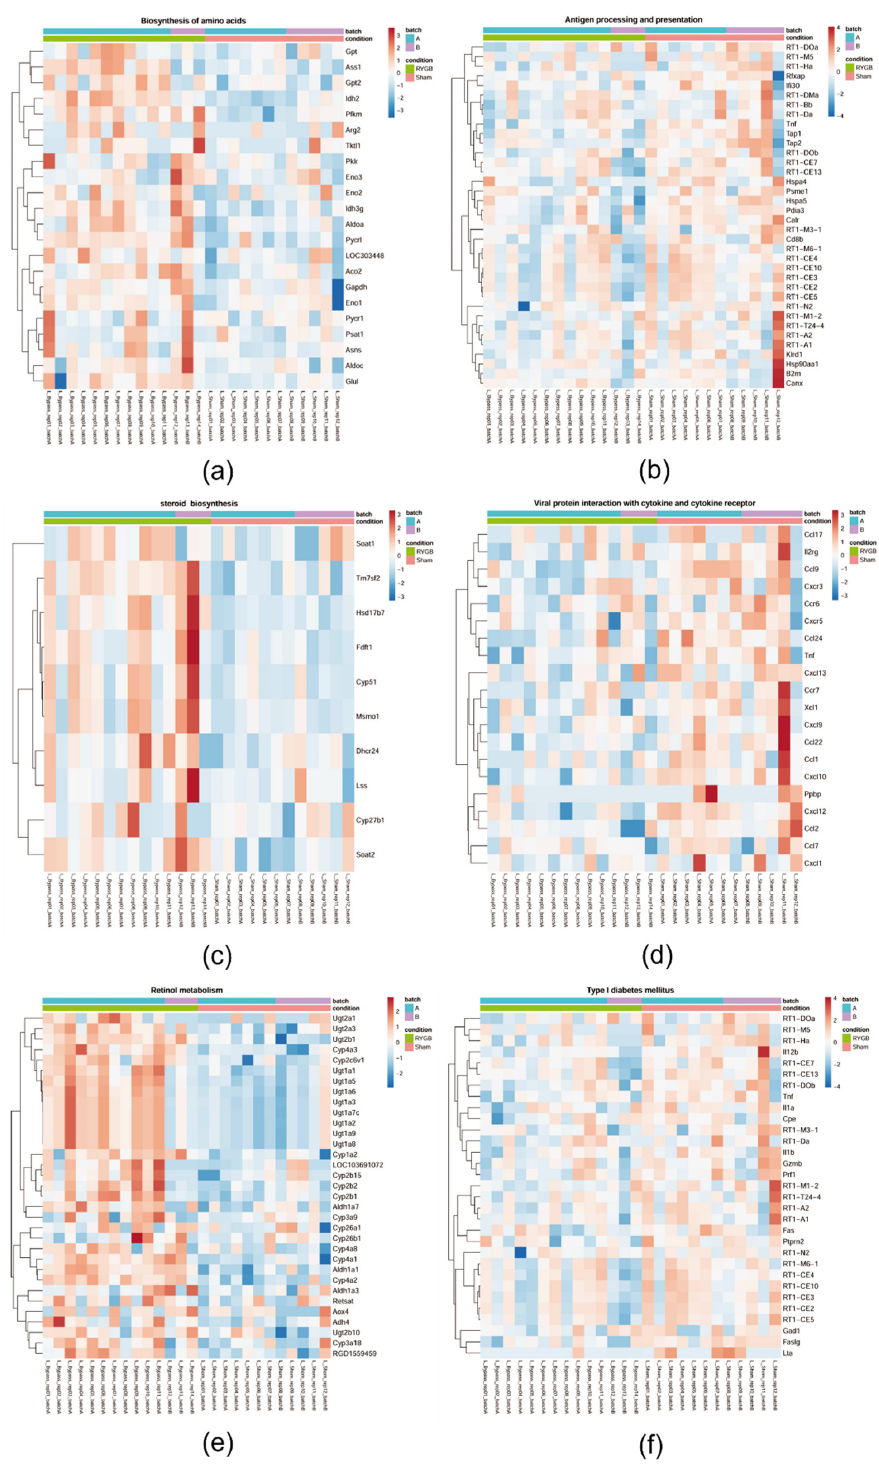
Figure 5. Heatmaps depicting gene expression levels in liver samples of RYGB vs. sham-treated animals for the GSEA-based core enrichment of selected significantly up- ( left ) or down-regulated ( right ) KEGG pathways ( p.adj ≤ 0.05). Expression values represent row-wise z-scores of VST-transformed read counts with higher expressed genes in red and lower expressed genes in blue. GESA, gene set enrichment analysis. ( a ) biosynthesis of amino acids, ( b ) antigen processing and presentation, ( c ) steroid biosynthesis, ( d ) viral protein interaction with cytokine and cytokine receptor, ( e ) retinol metabolism and ( f ) type I diabetes